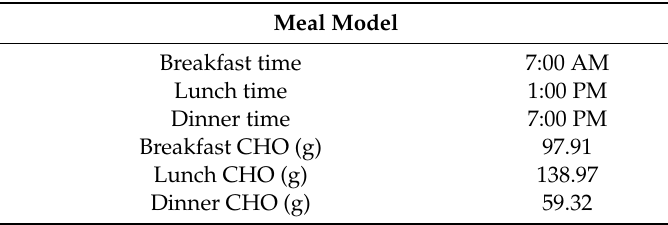
Table 2. Default parameter values for the proposed application.